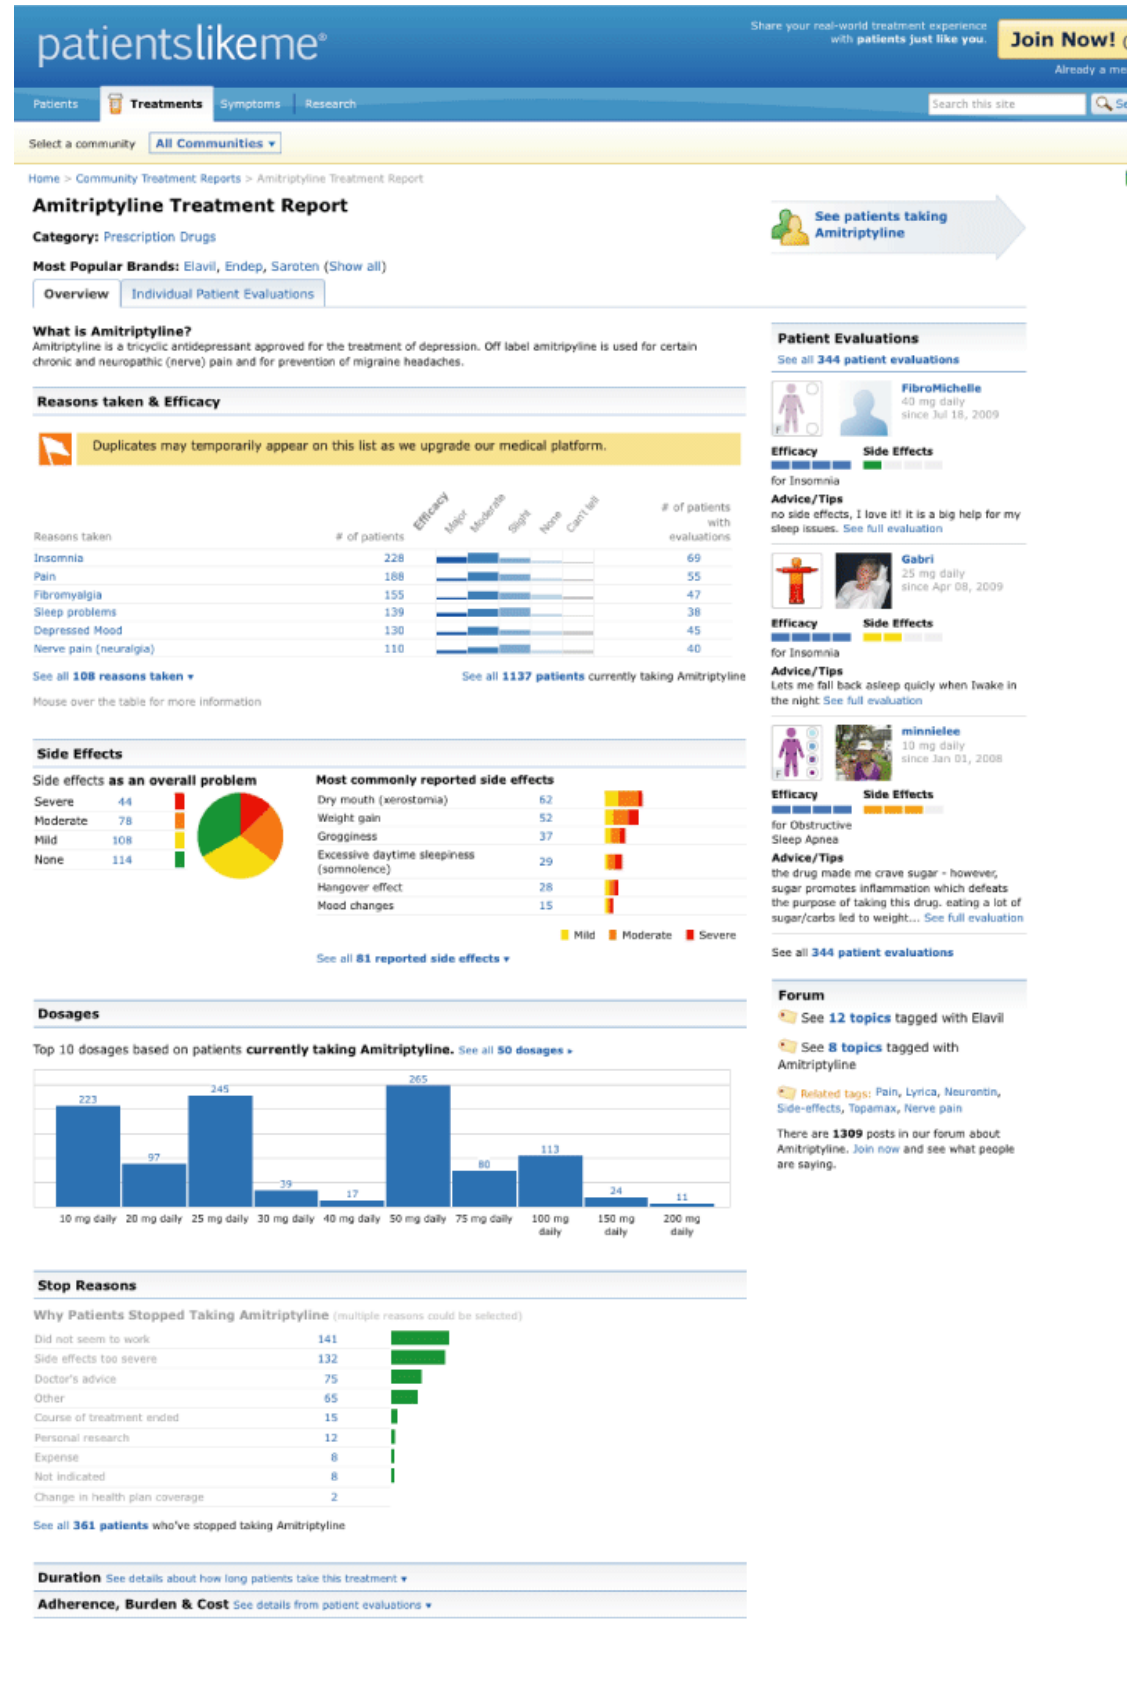
Figure 1. The treatment report for amitriptyline available on PatientsLikeMe. This treatment report was captured after the date of analysis; therefore, the data featured do not match the data